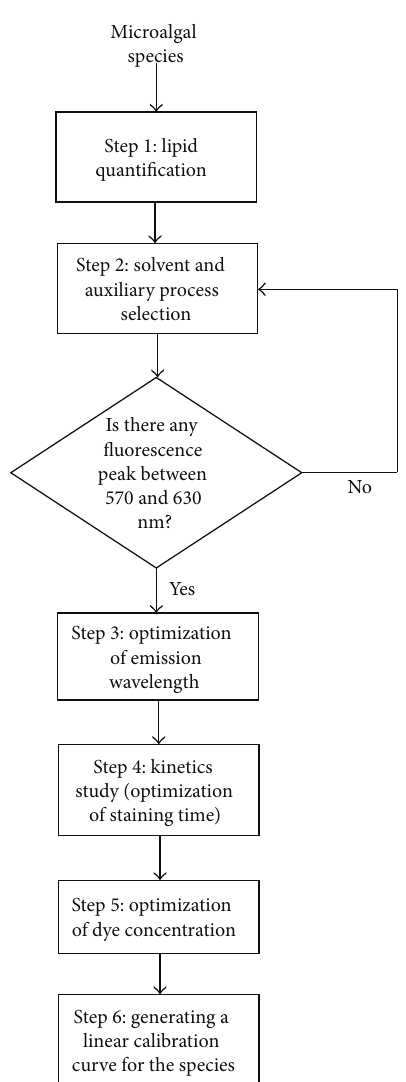
Figure 6: Operating framework for the optimization of Nile red staining of a new microalgal